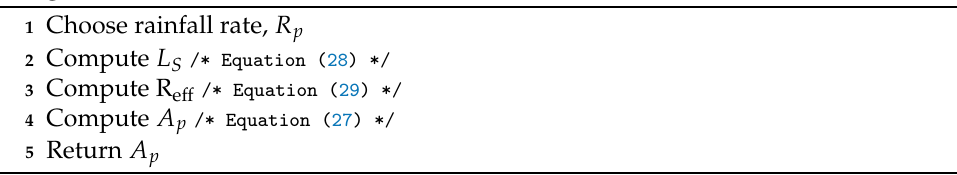
Algorithm 8: Unified Model